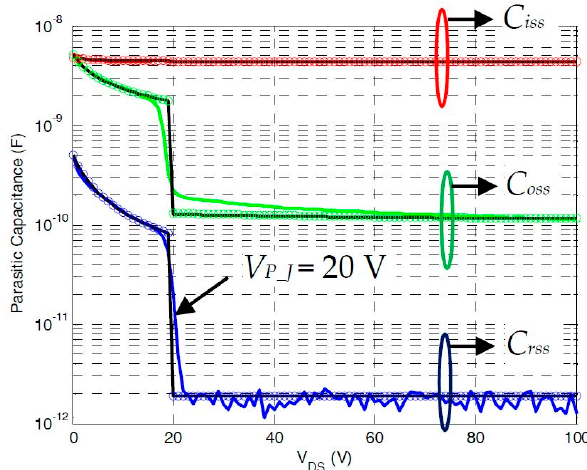
Figure 7. Parasitic capacitance of the fabricated GaN FETs (colored lines: measured, black line: simulation, circle: calculated).